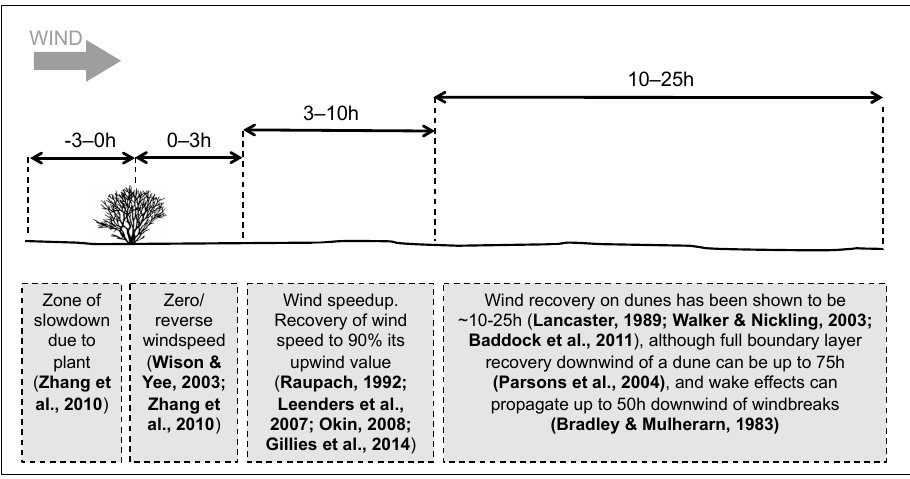
Figure 4. Main zones of possible speedup/slowdown around a roughness element, as collated from various vegetation and windbreak studies.